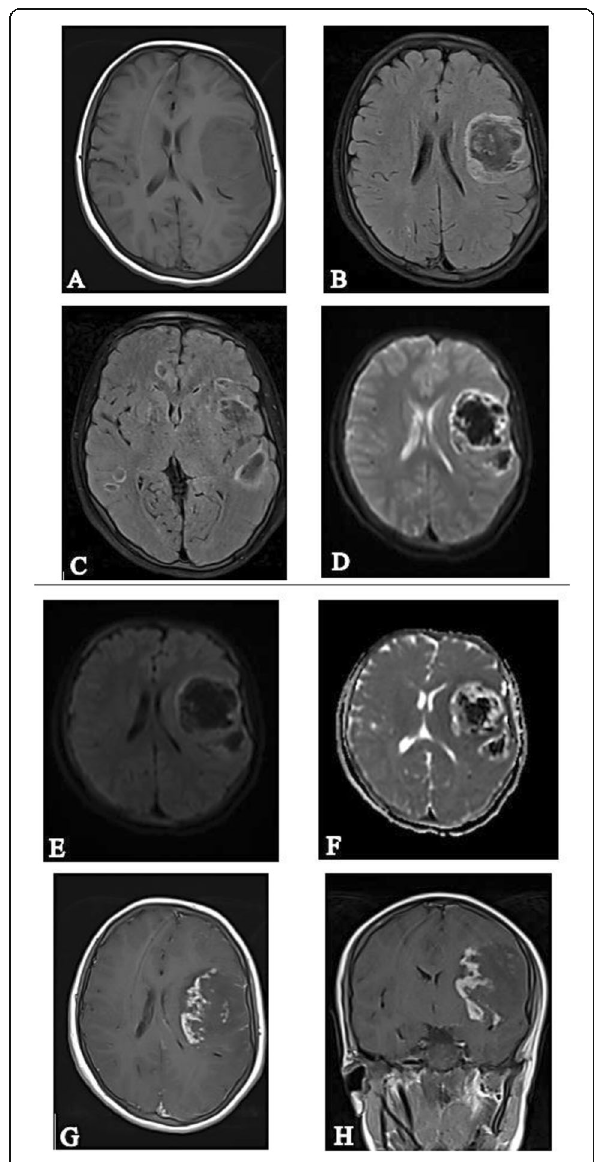
Fig. 8 Multiple intra axial fungomas. Male patient, 8 years old, diagnosed with AML at presentation. Axial MRI of the brain: a Axial T1TW, b , c axial FLAIR images showing left fronto-temporal intra-axial cortical-based SOL elicit intermediate signal in T1WI and Low FLAIR signal with rim of surrounding edema elicits high FLAIR signal. c Image shows other similar smaller lesions seen at both frontal and temporal regions. d Axial T2*, e axial DWI, and f axial ADC show blooming of the center of the lesions seen at T2* gradient image ( d ) with marginal diffusion restriction in DWI ( e ) and ADC map ( f ). The low signal in the center of the lesion may be corresponding to ferromagnetic fungal deposits (iron, manganese, magnesium, zinc). g Axial T1 post-contrast MRI. h Coronal post-contrast MRI of the same patient shows